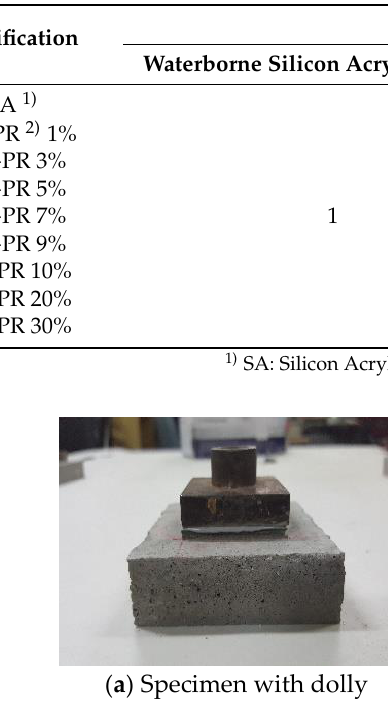
Figure 2. Specimen and apparatus of adhesion test. Table 7. Mix design of epoxy and urethane.